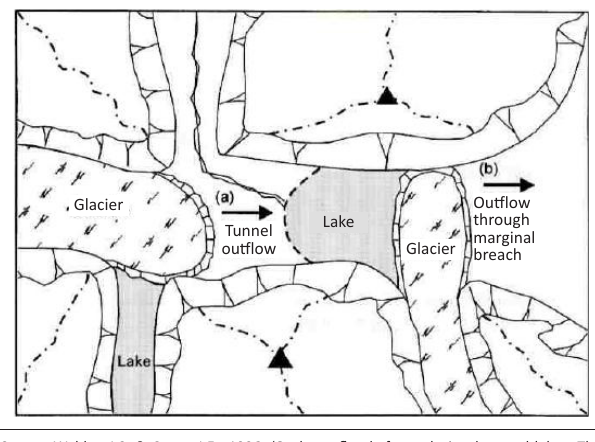
Source : Walder, J.S. & Costa, J.E., 1996, ‘Outburst floods from glacier-dammed lakes: The effect of mode of lake drainage on flood magnitude’, Earth Surface Processes and Landforms 21, 701–723 FIGURE 2: Two patterns of glacial lakes and their breach mechanisms, (a) indicating the flow of meltwater through a glacial body and (b) indicating the breaching of a glacier at its margins.